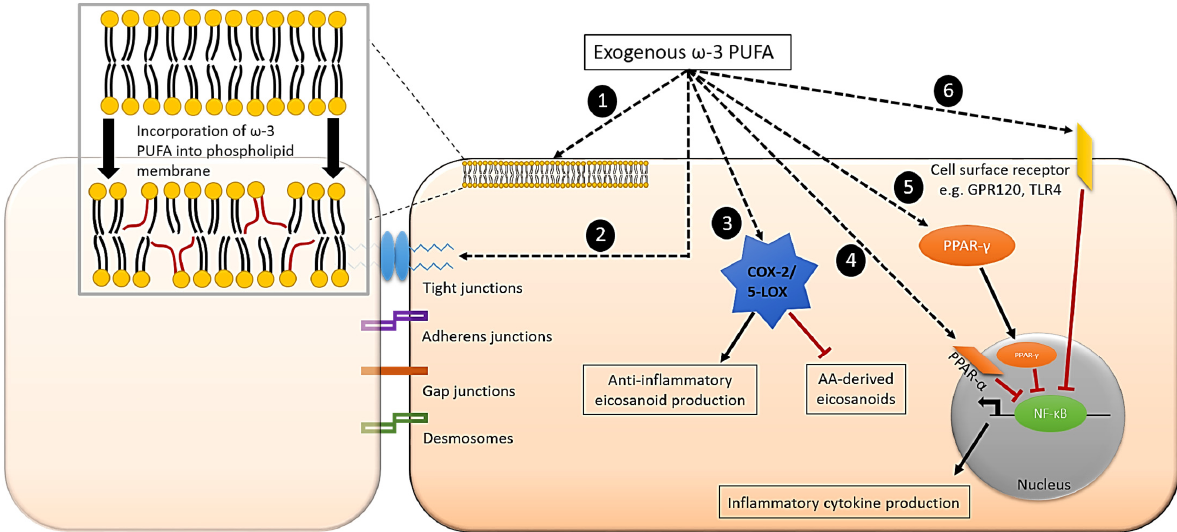
Figure 4. Proposed mechanisms involved in ω -3 PUFA regulation of inflammation in intestinal epithelial cells. ( 1 ). Incorporation of ω -3 PUFA into phospholipid membrane/lipid rafts. ( 2 ). Modulation of tight junction protein expression and redistribution. ( 3 ). Production of anti-inflammatory eicosanoids and inhibition of AA-derived eicosanoids catalysed by COX-2 or 5-LOX. ( 4 ). Activation of nuclear receptors, e.g., PPAR- α . ( 5 ). Translocation of transcription factors into nucleus, e.g., PPAR- γ . ( 6 ). Interaction with transmembrane/cell surface receptors, e.g., G-protein coupled receptor 120 (GPR120) and TLR4. Mechanisms 4, 5, and 6 lead to the inhibition of NF- κ B and the subsequent reduced production of multiple inflammatory mediators.